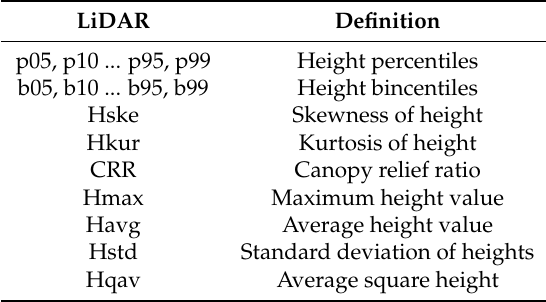
Figure 6. Schematic workflow for the regression-based estimation of canopy base height (CBH). Table 2. The LiDAR metrics used in this study for the construction of the plot-level CBH prediction regression model. The metrics refer to the pooled first-of-many and single echoes, pooled last-of-many and single echoes, last-of-many, first-of-many and total